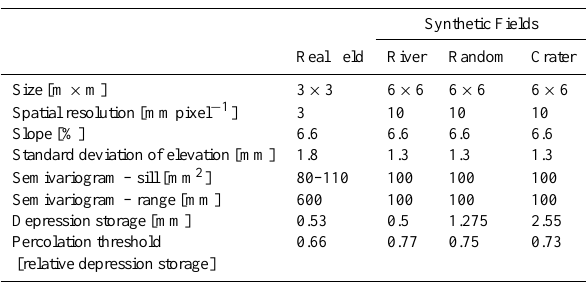
Table 1. Main characteristics of the